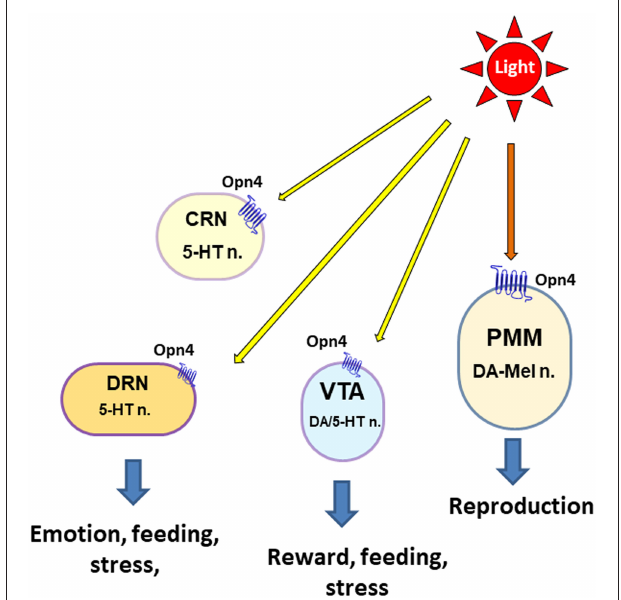
FIGURE 2 | Schematic overview of extraocular light perception in the midbrain and brain stem of avian species for the physiological response. The following abbreviations are used in the figure: 5-HT, serotonin; DA, dopamine; CRN, caudal raphe nucleus; DRN, dorsal raphe nucleus; n, neuron; PMM, premammillary nucleus; VTA, ventral tegmental